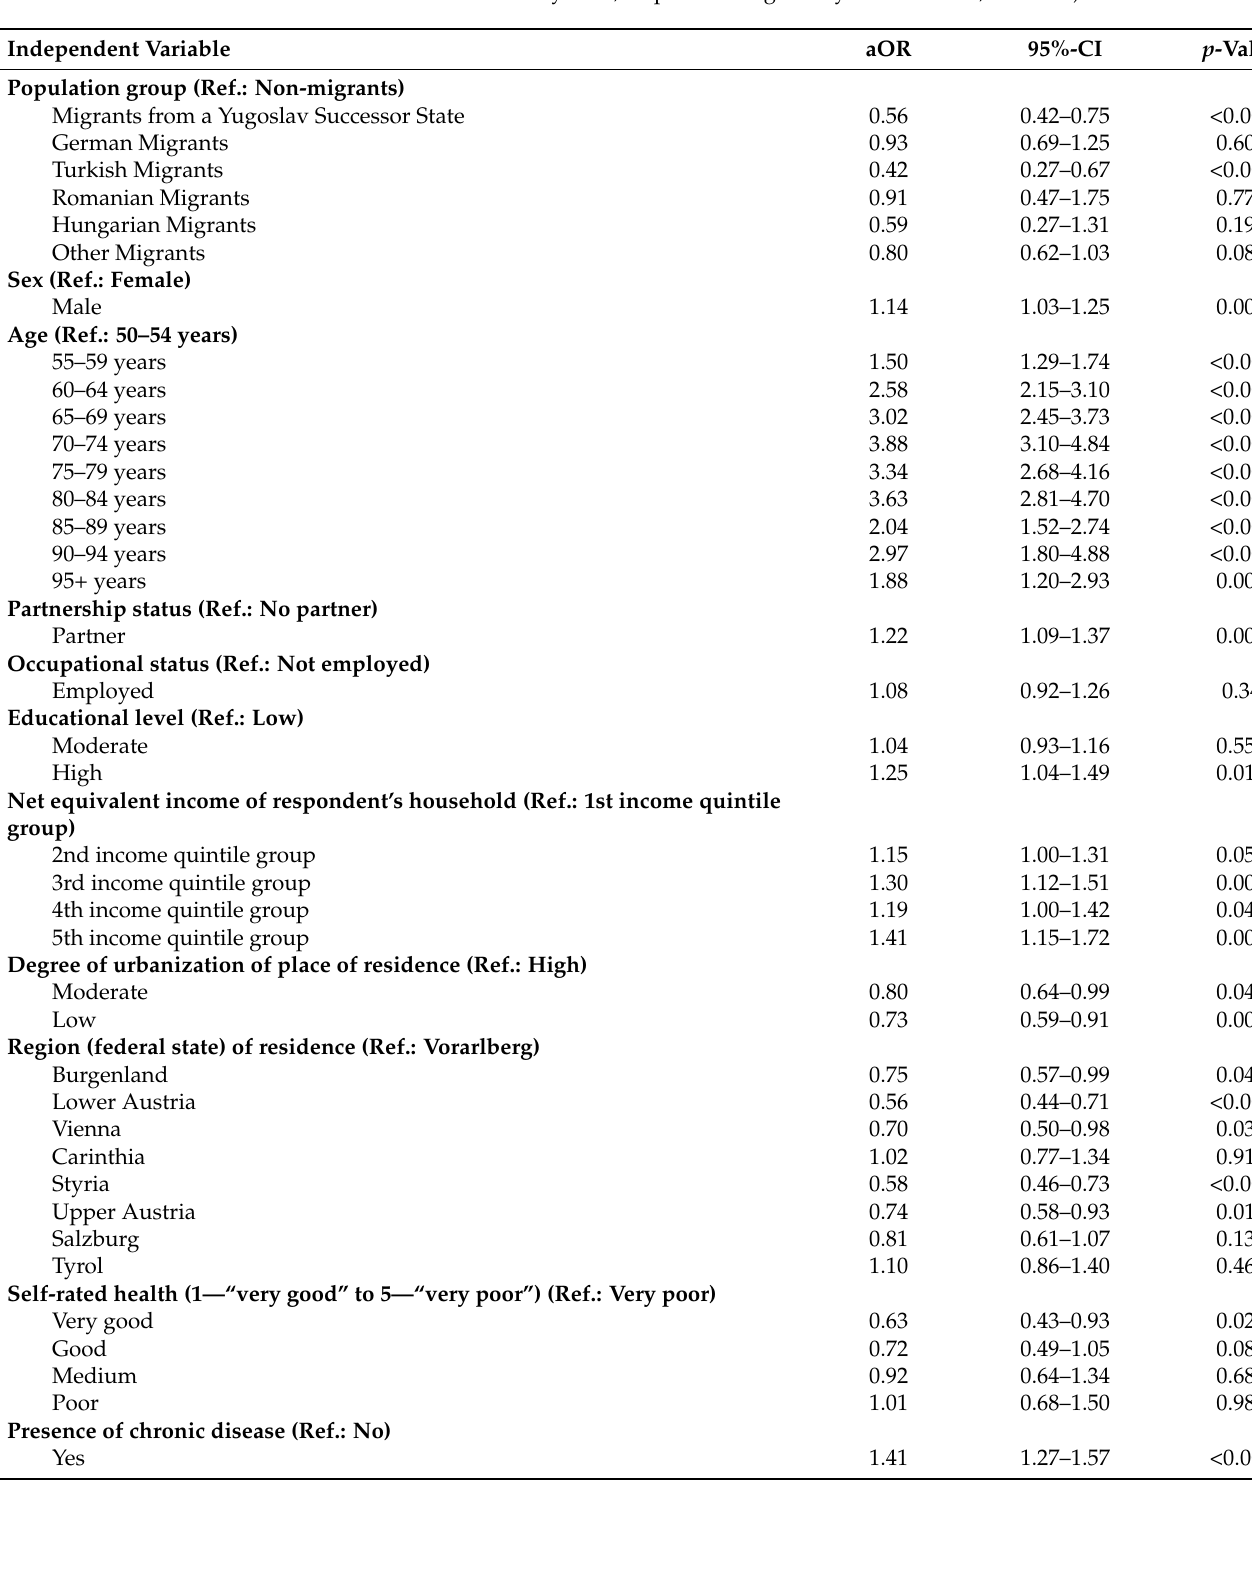
Table 3. Results of the multivariable logistic regression model with utilization of colonoscopy as